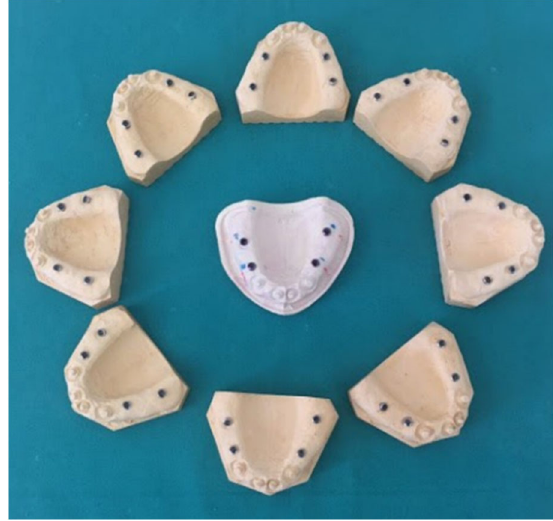
Figure 7. Definitive working models with embedded implant body analogs.